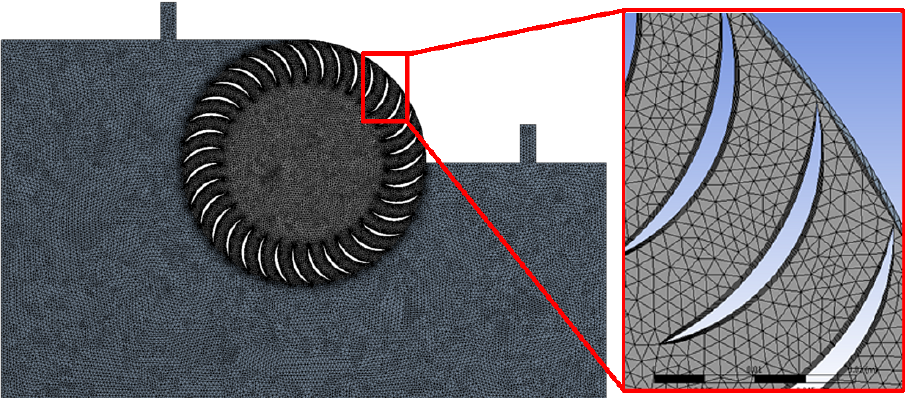
Figure 7. Mesh of the physical domains for the simulation with a 35 blade